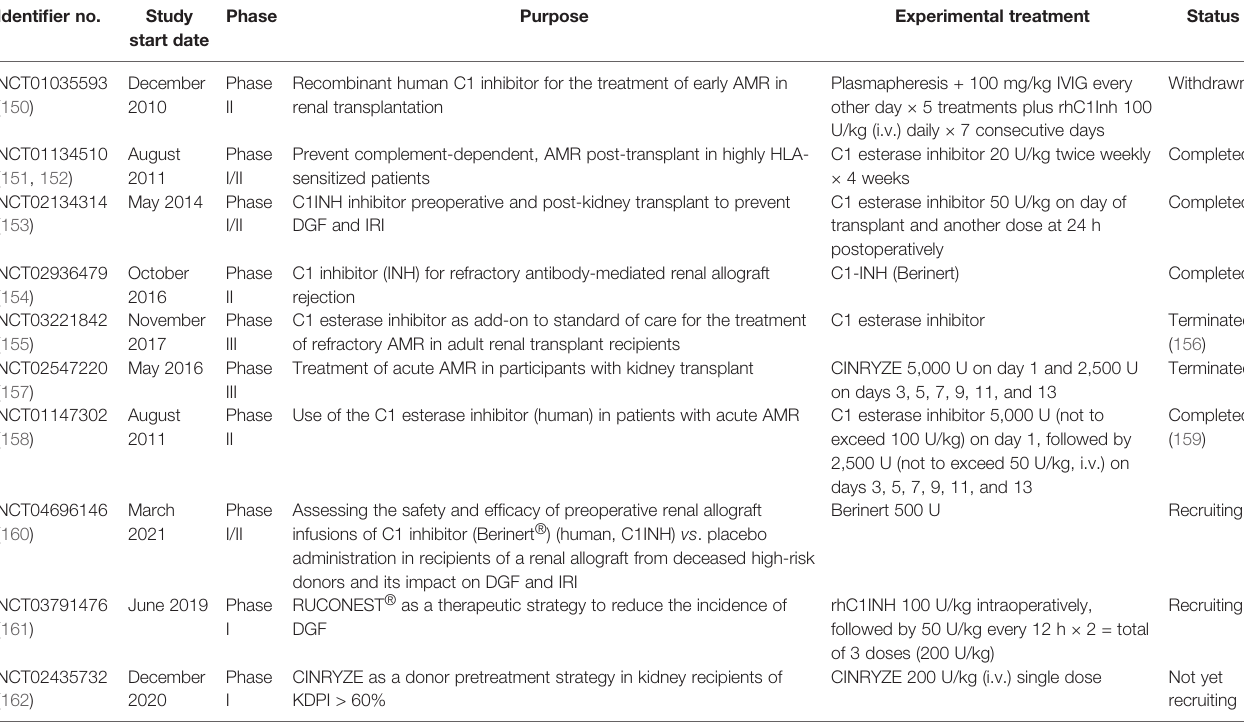
TABLE 3 | Clinical trials of C1-INH in kidney transplantation. Identi fi er